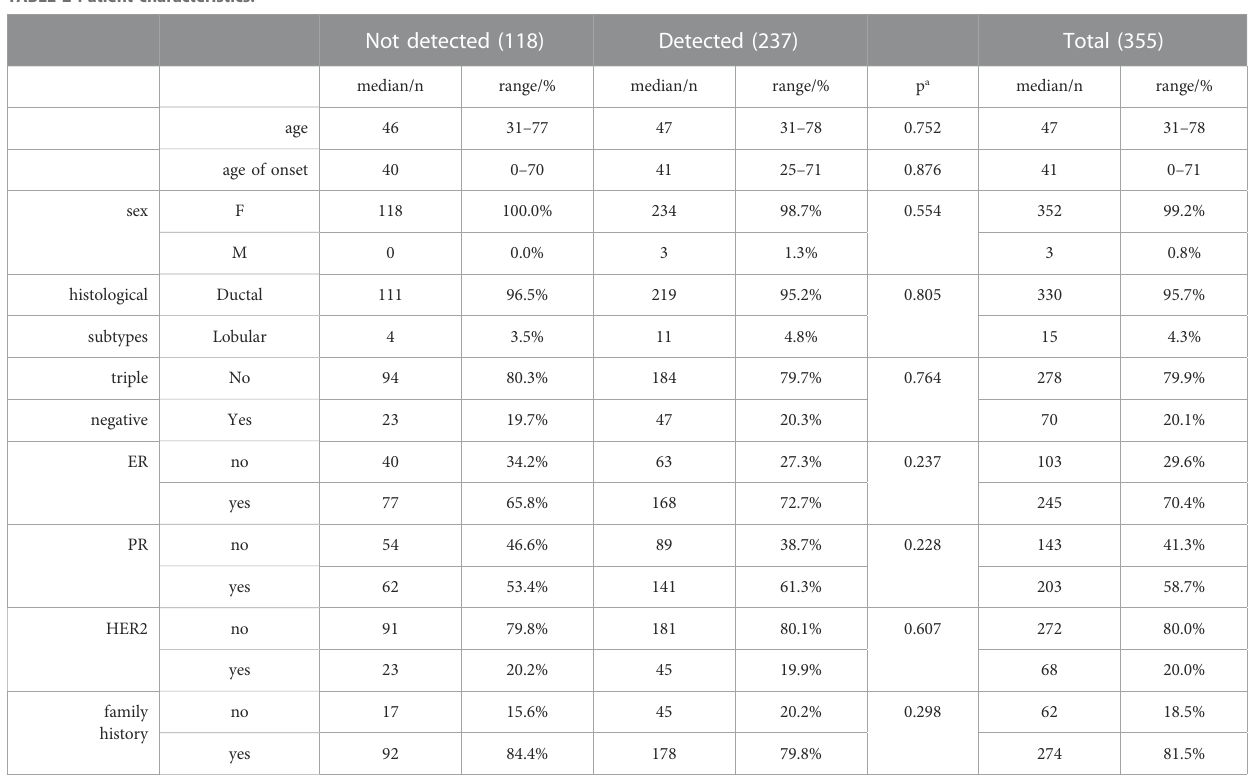
TABLE 2 Patient